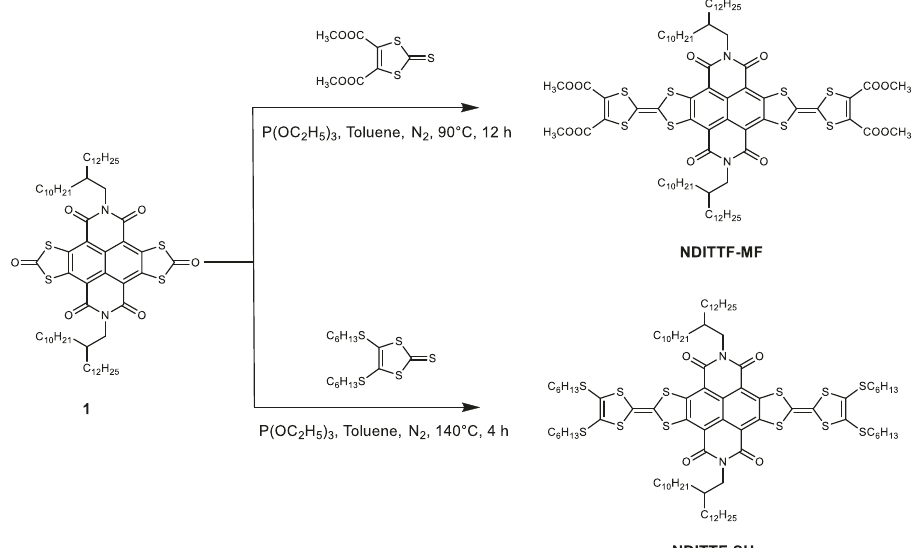
Fig. 1 Chemical structures of NDITTF-MF and NDITTF-SHe and their synthetic approaches. Conductance measurements. We fi rstly probe the electronic transport properties of the four carboxylic acid methyl ester groups terminated TTF molecule (NDITTF-MF, see Fig. 1) using the scanning tunneling microscope-break junction (STM-BJ) technique (Fig. 2a), which can measure single-molecule conductance at room temperature in ambient environment 8,30 . Brie fl y, we repeatably drive a gold STM tip in and out of contact with a gold substrate in 1,2,4-trichlorobenzene (TCB) solution of NDITTF- MF molecule (0.01 – 0.1 mM). After the Au – Au point contact is broken, the molecule can bridge the two electrodes and form a single-molecule junction. We measure the conductance as a function of the tip-substrate displacement during this process. The inset of Fig. 2b shows sample conductance traces of NDITTF-MF measured at an applied tip bias of 0.5 V. A clear conductance plateau appears at ~10 − 2 G 0 (where G 0 = 2 e 2 / h is the quantum of conductance), indicating the formation of single-molecule junctions of NDITTF-MF.